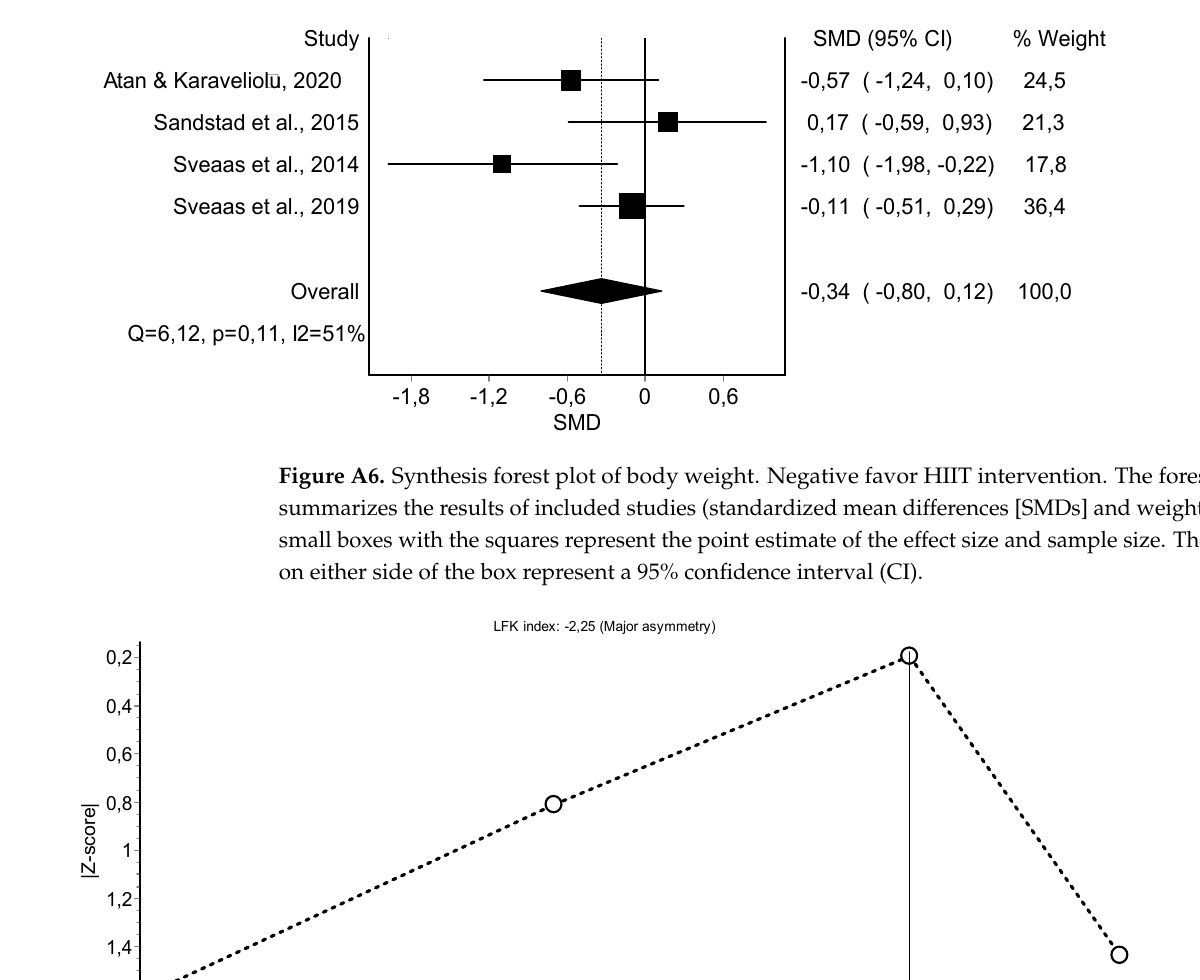
Figure A5. Synthesis funnel and Doi plot (LFK index) for resting diastolic blood pressure.